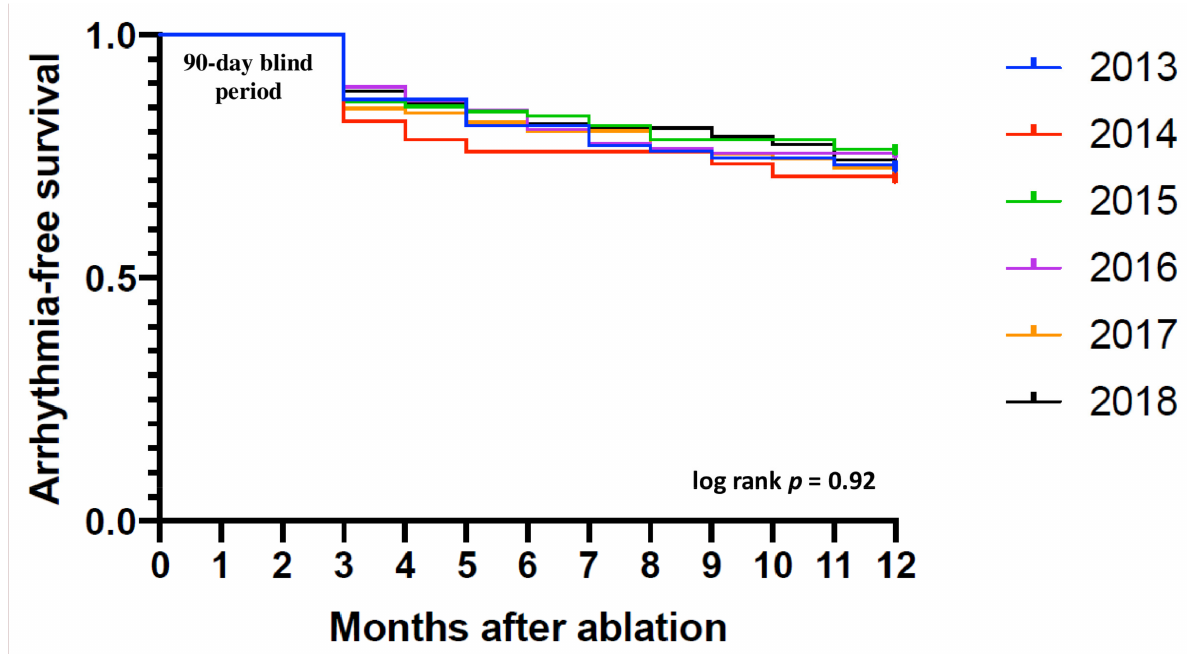
Figure 5. Kaplan–Meier curve showing time to the first recurrence of symptomatic or asymptomatic AF/AFl/AT up to the 12-month follow-up after ablation in consecutive years. Abbreviations: AF— atrial fibrillation, AFl—atrial flutter, AT—atrial